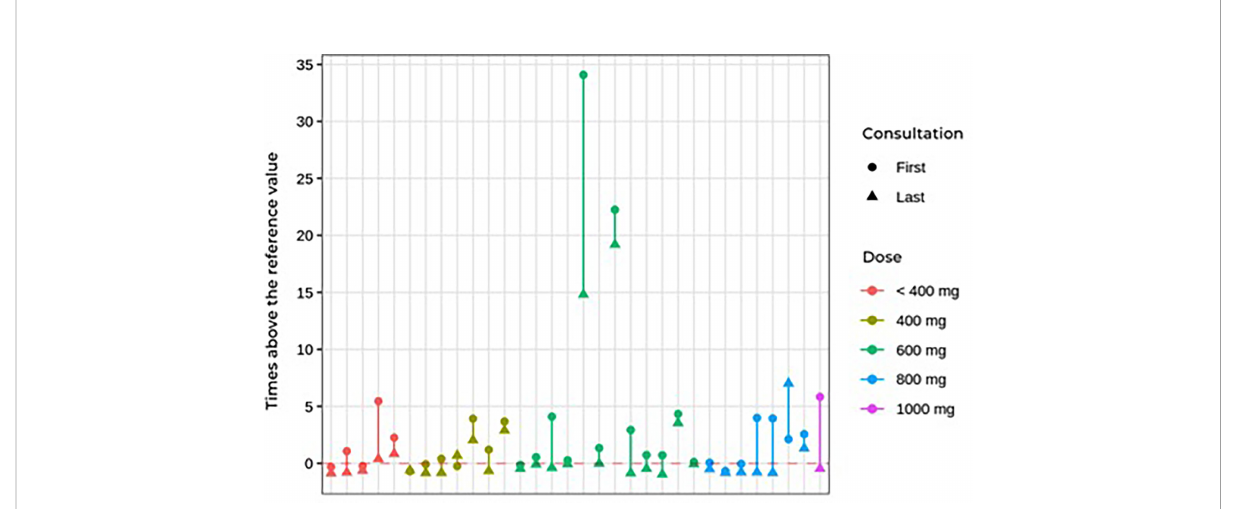
FIGURE 3 First and last consultation 24çhour UFC results vs. ketoconazole dosage in Cushing's disease